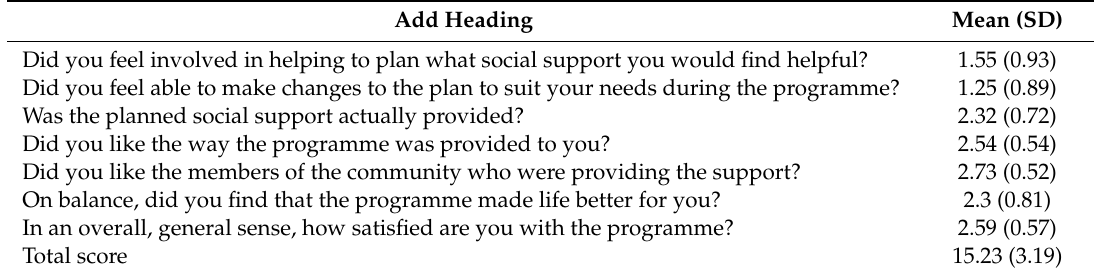
Table 6. Mean scores on the Social Support Programme Acceptability Rating Scale: Six items and total score, 4 points Likert scale (0 = not at all; 1 = a little: 2 = quite a lot; 3 = a great deal), n =